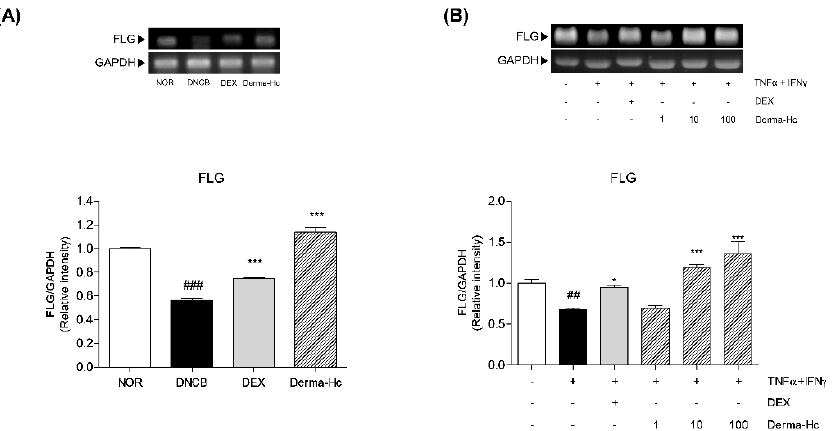
Figure 6. Derma-Hc recovers the expression level of FLG in ( A ) DNCB-induced mice and ( B ) TNF- α +IFN- γ -treated human keratinocytes. NOR, Normal saline-treated group; DNCB, 2,4-dinitrochlorobenzene (DNCB)-sensitized group; DEX, DNCB-sensitized and dexamethasone-treated group. The mRNA level of FLG was analyzed by RT-PCR. Three repeats of an experiment were conducted. The data are presented as mean ± standard error of the mean. ## p < 0.01 and ### p < 0.001 compared to NOR group. * p < 0.05 and *** p < 0.001 compared to individual groups. FLG, filaggrin; GAPDH, Glyceraldehyde 3-phosphate dehydrogenase.